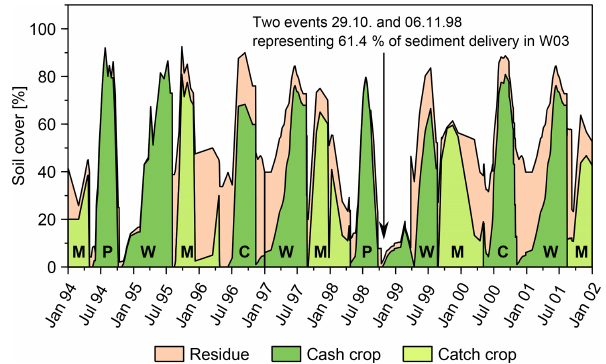
Figure 6. Averaged soil cover derived from measurements within the field drained by watersheds W03 and W04; between 1994 and 1996 the cover was measured; from 1997 to 2001 the soil cover was derived from the average cover measurements (1994–1996), taking into account the crop and the year-specific times of field operations within the test field occurring from 1997 to 2001 (W: wheat, C: maize, P: potato, M: mustard used as catch crop) (modified after Fiener et al., 2008). The arrow indicates the timing of the combined largest two soil delivery events in this watershed. Figure 7. K factor map of the research farm; K factor was deter-